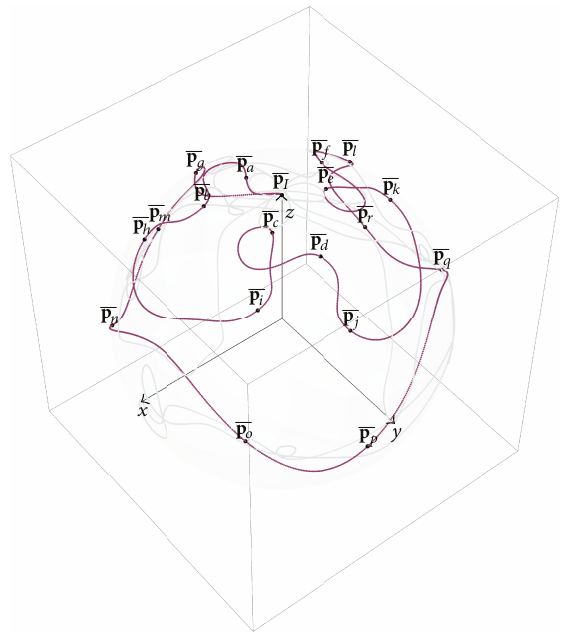
Figure 8: Motion of the body frame of the spacecraft in experiment C with 18 target attitudes. The traces of the x - and y -axes on the unit sphere are represented in grey, whereas the trace of the z -axis is represented in